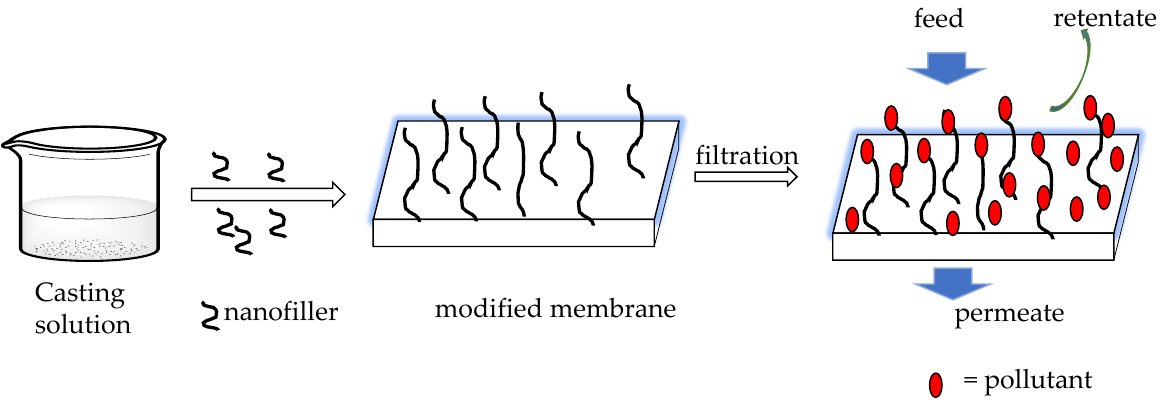
Figure 4. Illustration of polymer modification and filtration.